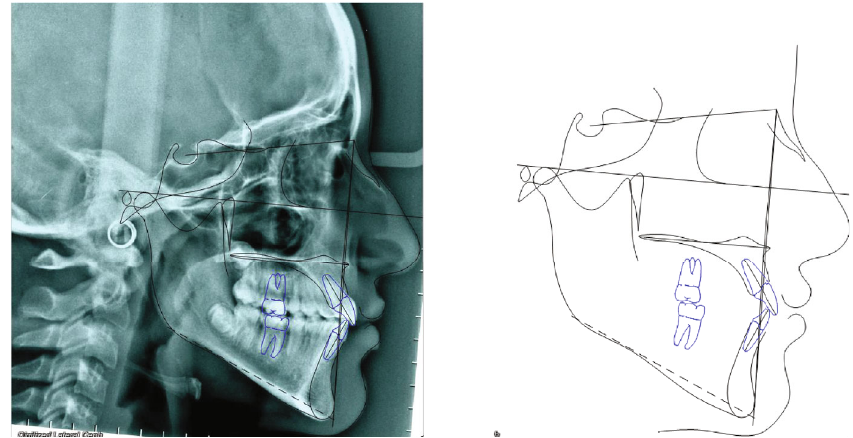
Figure 8: Case no. 1 tracings at T 2 Table 1: Cephalometric values of case no. 1 before treatment, after PS3 treatment, and at the end of fi xed appliance treatment.